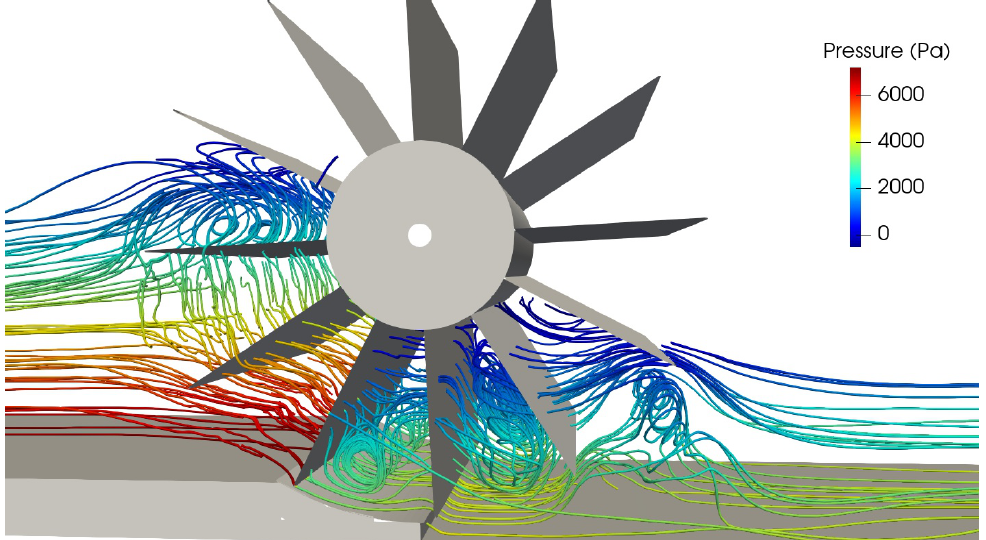
Figure 19. Image of instantaneous streamlines through the HPM colored by pressure, Q = 58.9